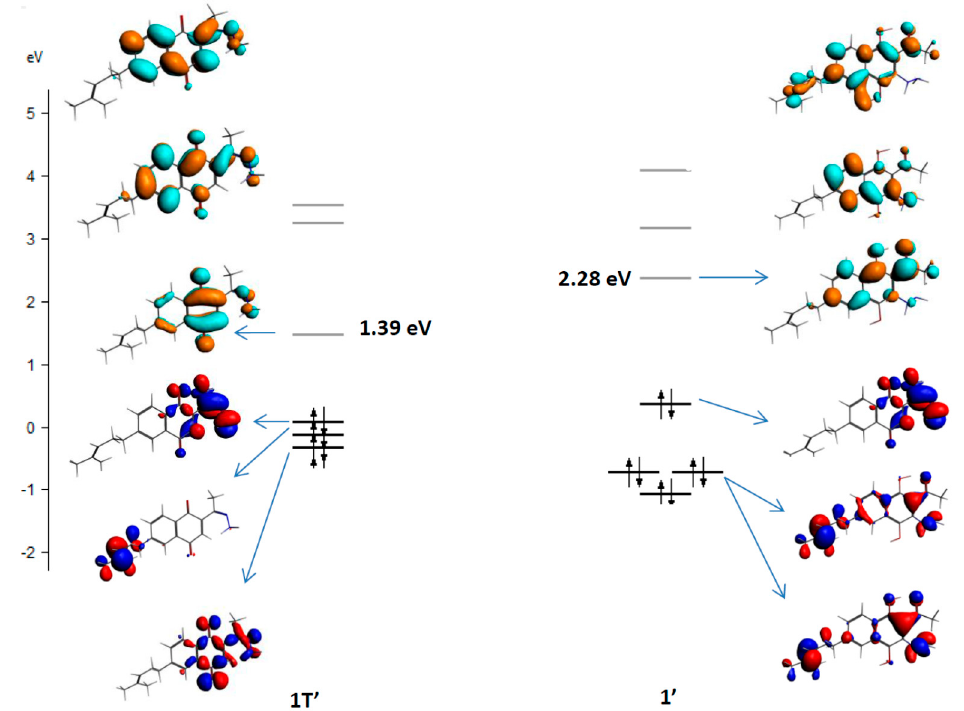
Figure 1. Molecular orbital diagrams of compounds 1T’ and 1’ . The HOMO energies have been arbitrarily set to zero for clarity.